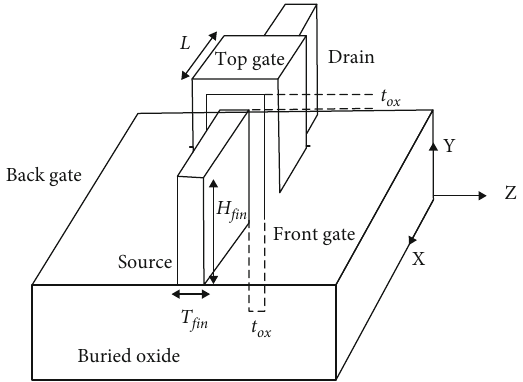
Figure 1: Structure of a basic 3D